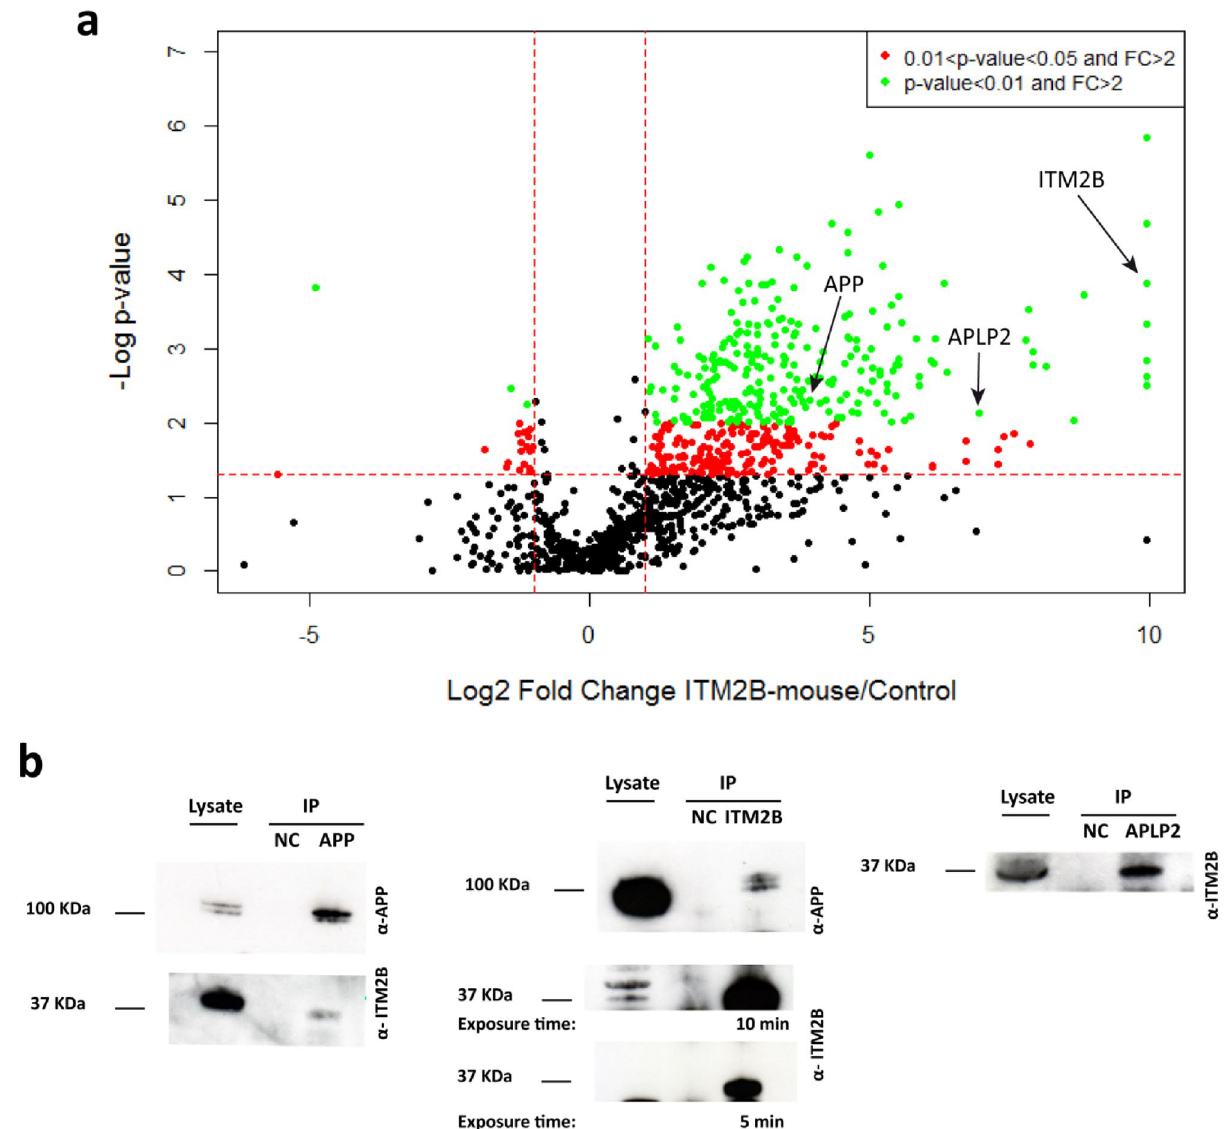
Figure 3. ( a ) Volcano plot with − log10 p-value vs. log2 FC (mouse anti-ITM2B/unspecific antibody). Each point represents an identified protein. Proteins with significantly different abundances (in red 0.01 < p-value < 0.05, in green p-value < 0.01) are above the horizontal red line. On the right side are the proteins enriched with the mouse anti-ITM2B antibody with a FC > 2 while on the left side are the proteins enriched with the unspecific antibody with FC > 2. ( b ) Co-immunoprecipitation of APP and APLP2 from the human retina. The IP for negative controls (NC) was performed using Dynabeads and mouse IgG (isotypic control). Raw data of Western blots are presented in Supplementary Fig.